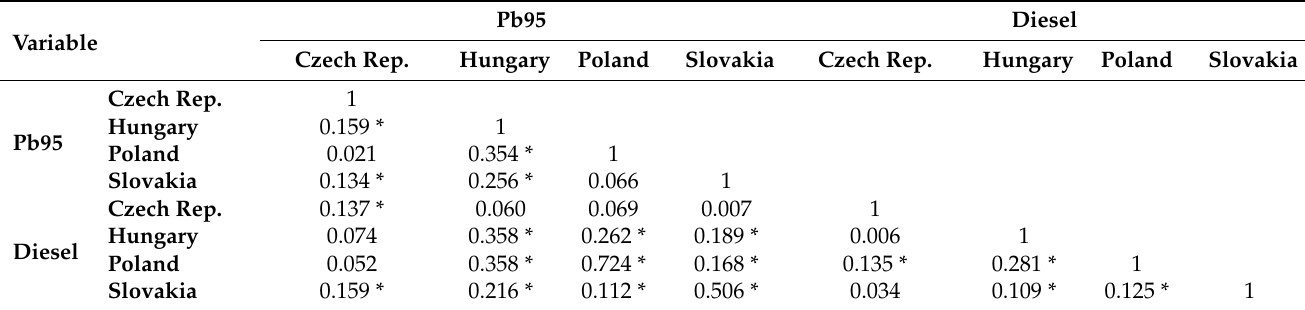
Table 3. Matrix of correlation coefficients between fuel log-returns.